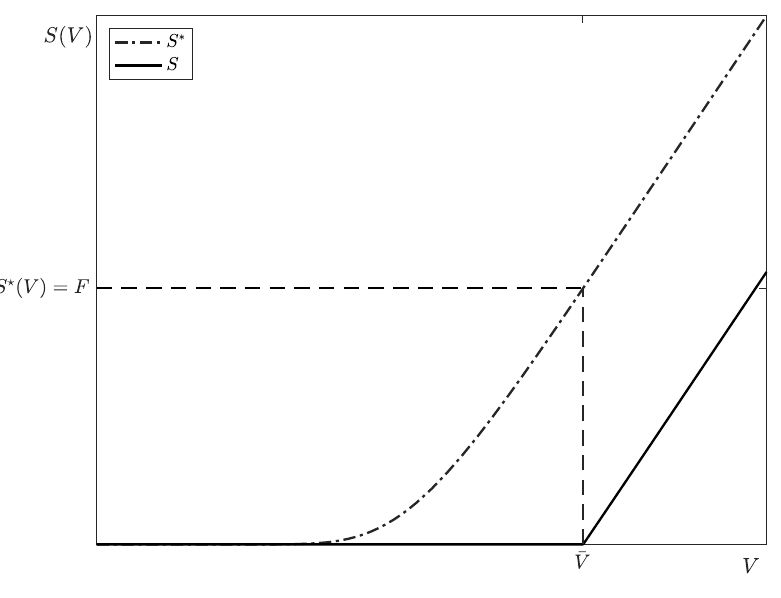
Figure 1. Continuation value (dashed and dotted line) and value (solid line) of the equity. Checking whether the continuation value of the equity S (cid:63) is greater than the face value of the bond F is equivalent to finding the value of the assets V greater than the default threshold ¯ V